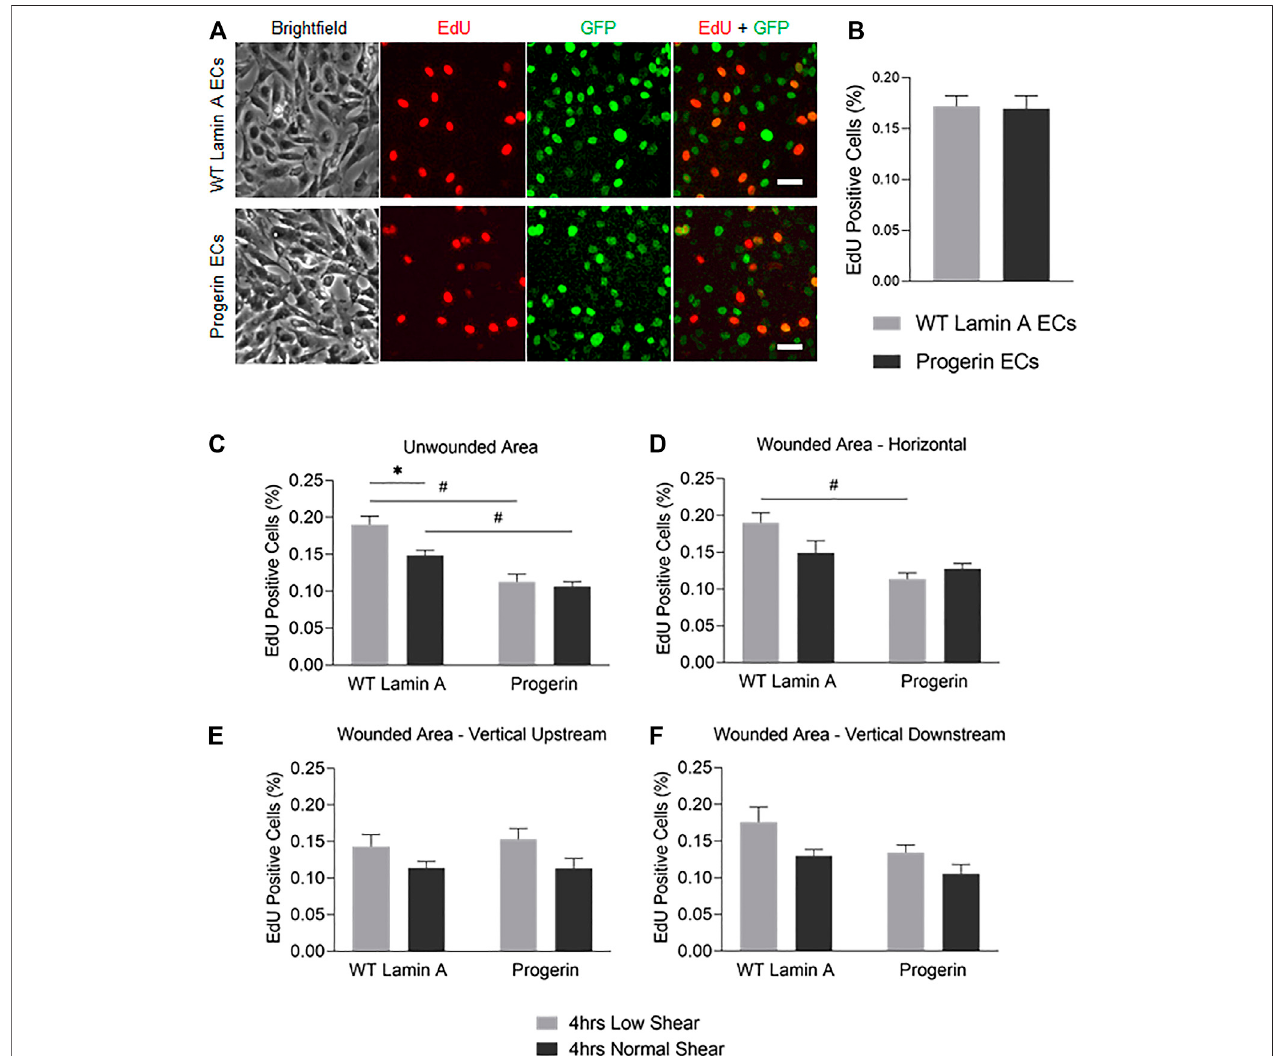
FIGURE5|(A) Demonstrativeimagesofcomparableproliferationratesinwild-typelaminA-andprogerin-expressingECsthatwereculturedwithinweeks2and3. Cells were incubated in 10 µM EdU in growth medium for 2 h before fi xation. Dyes and channels used: red channel for EdU, green channel for the presence the external proteins fused with GFP. Scale bar: 40 µm. (B) Quanti fi cation of comparable proliferation rates in transduced ECs that were cultured within weeks 2 and 3. (C – F) The percentages of EdU-positive cells at unwounded area (C) , horizontal wound edges (D) , and vertical wound edges at upstream (E) and downstream regions (F)